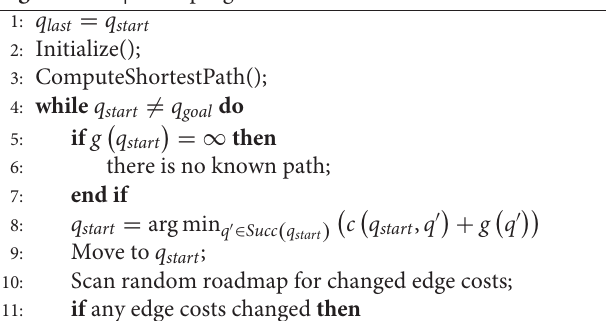
Algorithm 3 | Main program of D*